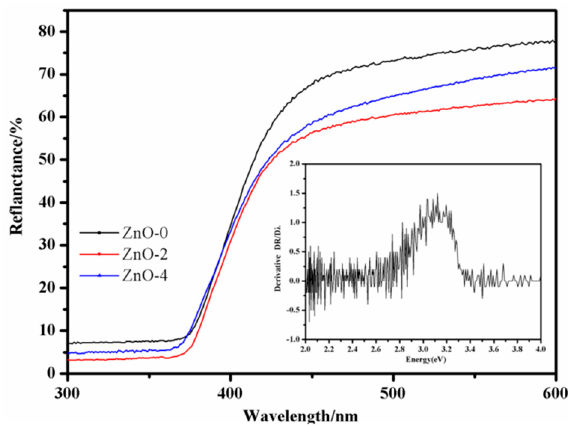
Figure 5. Diffuse reflectance measurement of the samples ZnO-0, -2 and -4, together with the first derivative of ZnO-2 (inset) to describe the band gap.